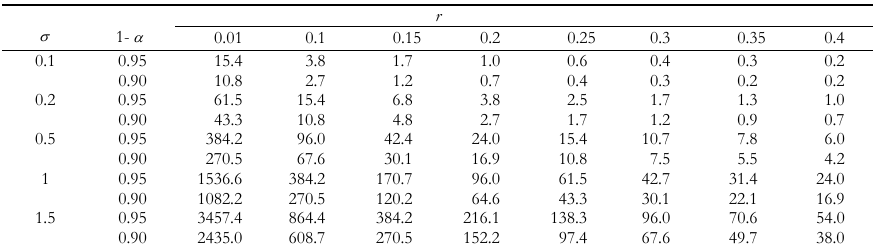
Theoretical sample sizes for the mean, controlling for absolute errors, standard deviations, and significance levels  =0.05, 0.1